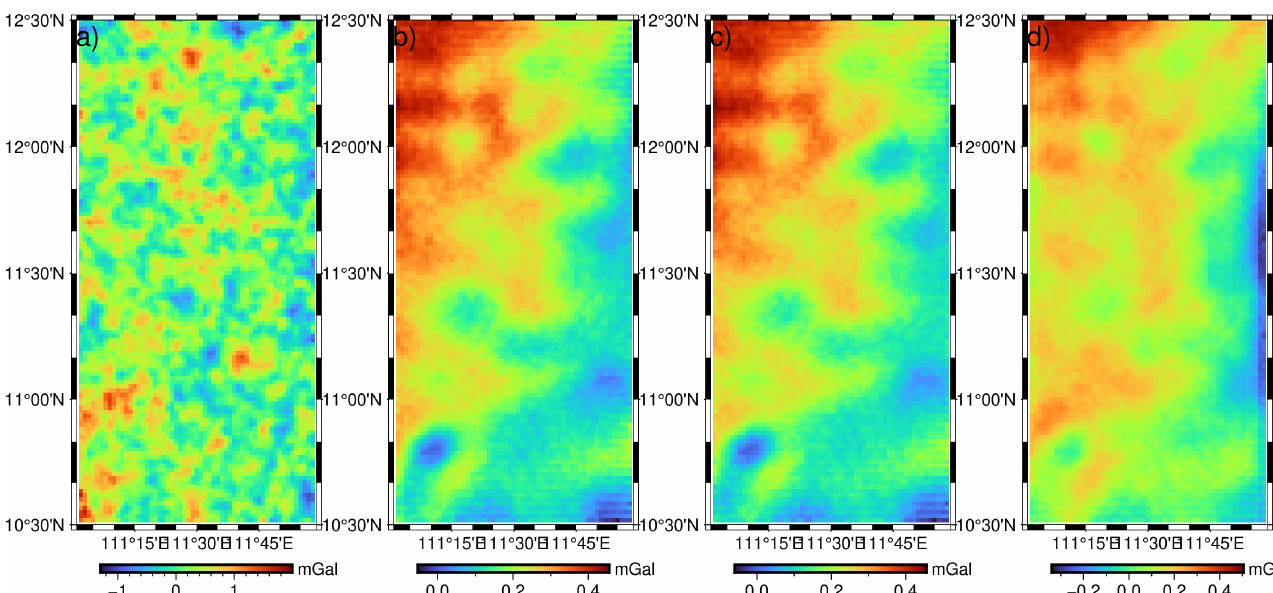
Figure 12. GA errors caused by: ( a ) wet troposphere; ( b ) dry troposphere; ( c ) ionosphere; ( d ) SSB. Table 4. Statistics of GA errors caused by different residual environmental errors (unit: mGal).